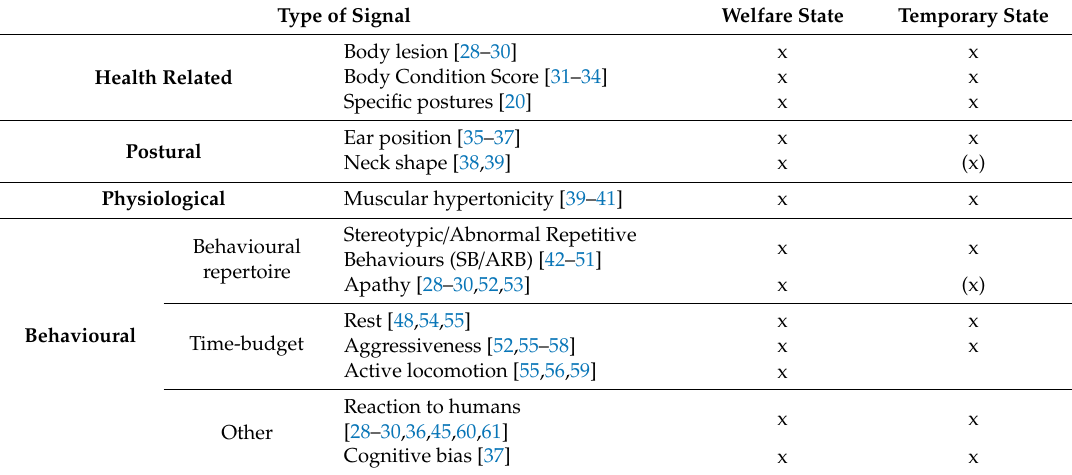
Table 1. Indicators of horses’ welfare. X: specifies whether the indicator may reveal a temporary state or a veterinary issue as well as welfare. (X): indicates whether signal may be a predictor of chronic welfare state, temporary state or a veterinary issue when combined with other signals. References are given in italics for each